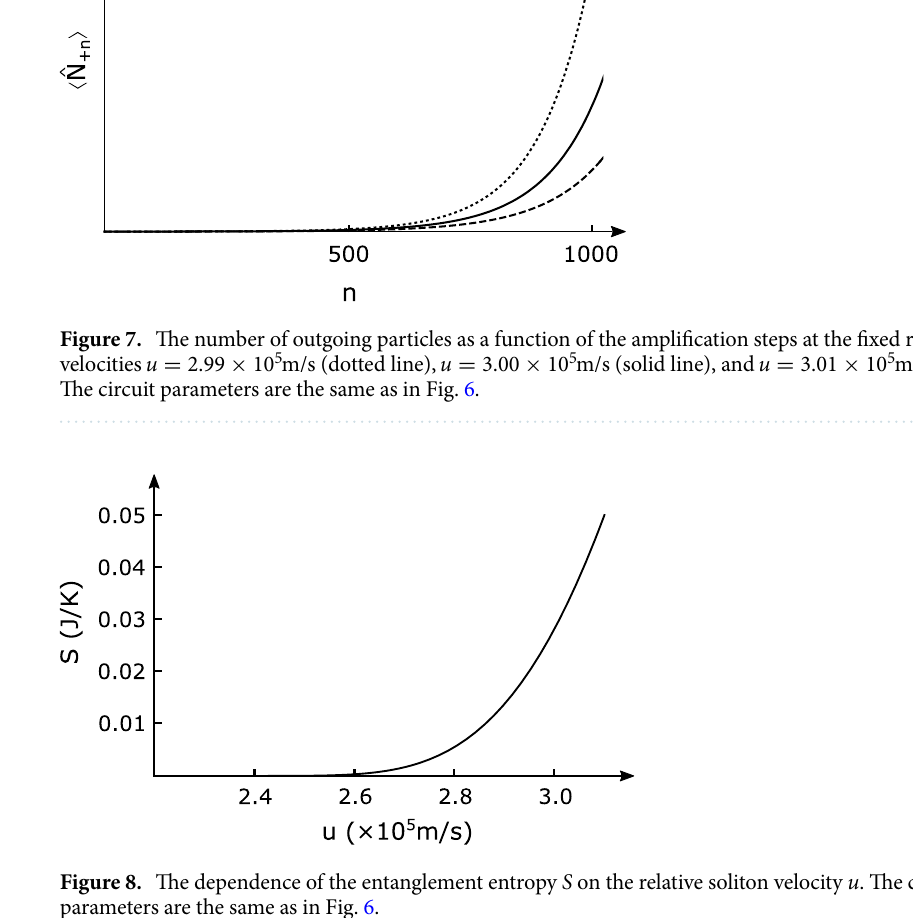
Figure 8. The dependence of the entanglement entropy S on the relative soliton velocity u . The circuit parameters are the same as in Fig.